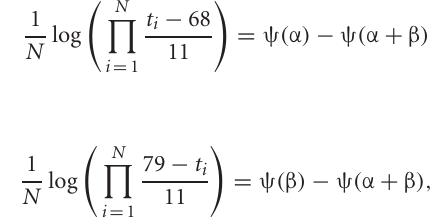
and 75, respectively. The greater the number of dots in B (more precisely, the sum of the probability masses at positions spanned by B) compared to the number of dots in both A and C, the greater the triangle